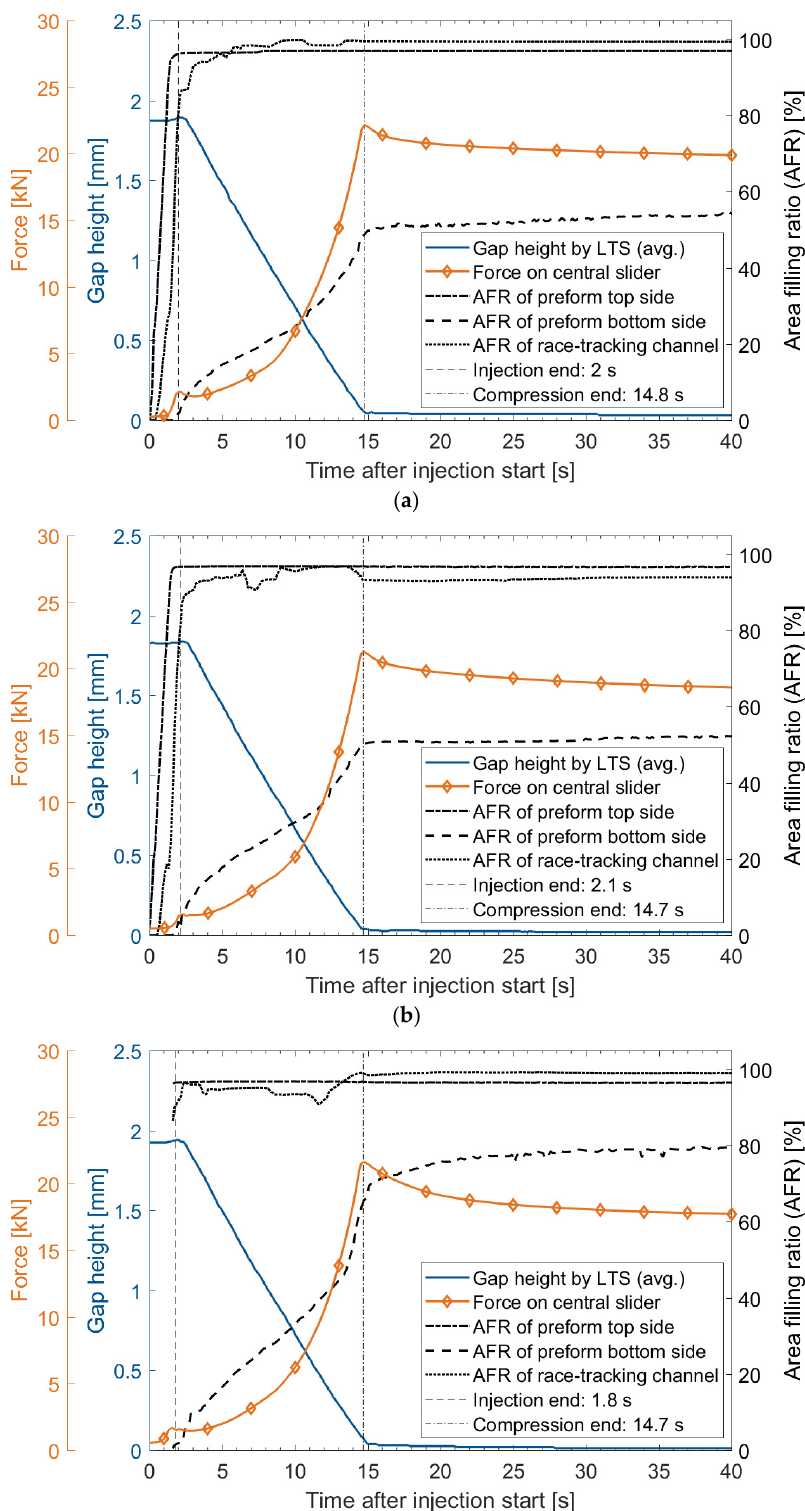
Figure A4. Overview of important process variables during FS-CRTM experiments of the race- tracking study: ( a ) medium race-tracking width—mrt-#2; ( b ) wide race-tracking width—wrt-#2; ( c ) wide race-tracking width—wrt-#3—no pictures of the preform top side were recorded during the injection of wrt-#3 due to issues of the data acquisition equipment (LTS = laser triangulation sensor).